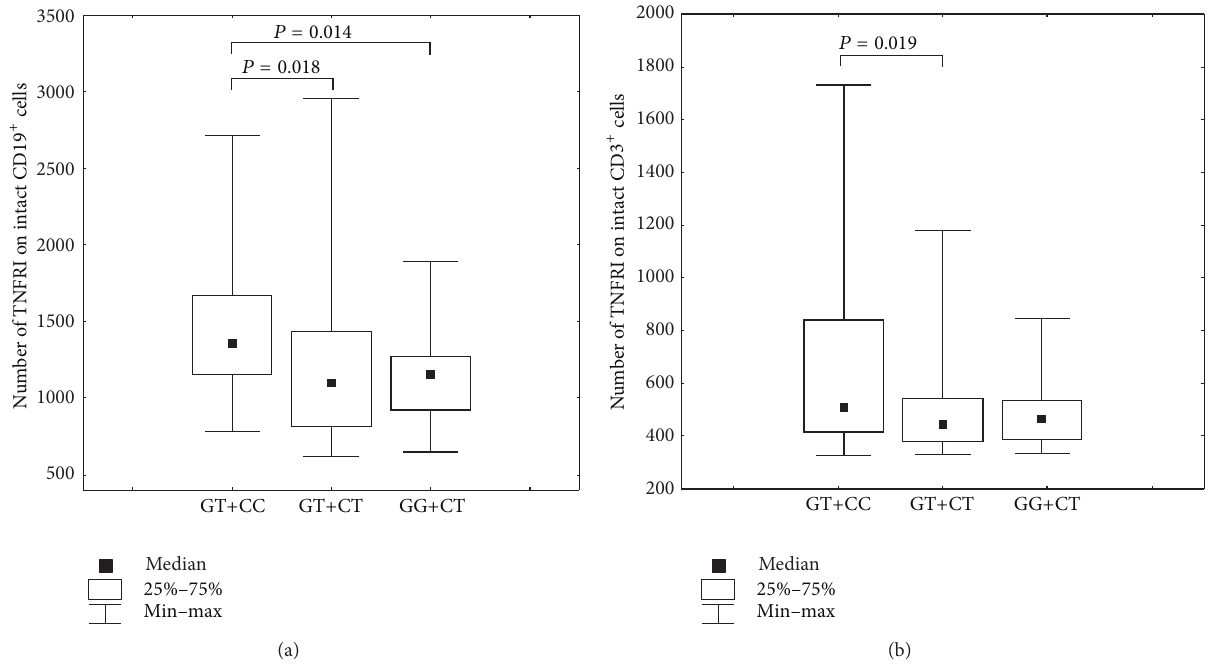
Figure 4: (a) Number of membrane-bound TNFRI present on CD19 + cells in individuals presenting with different genotypes combinations of SNPs TNFRI − 609G/T(rs4149569)and TNFRII − 3609C/T(rs590368).Kruskal-Wallis 𝐻 test, 𝑃 = 0.02 ,Mann-Whitney 𝑈 test:GT+CCversus GT+CT, 𝑃 = 0.02 , GT+CC versus GG+CT, 𝑃 = 0.014 . (b) Number of membrane-bound TNFRI present on CD3 + cells in individuals with different genotypes combinations of SNPs TNFRI − 609G/T (rs4149569) and TNFRII − 3609C/T (rs590368). Kruskal-Wallis 𝐻 test, 𝑃 = 0.05 , Mann-Whitney 𝑈 test: GT+CC versus GT+CT, 𝑃 = 0.02 .